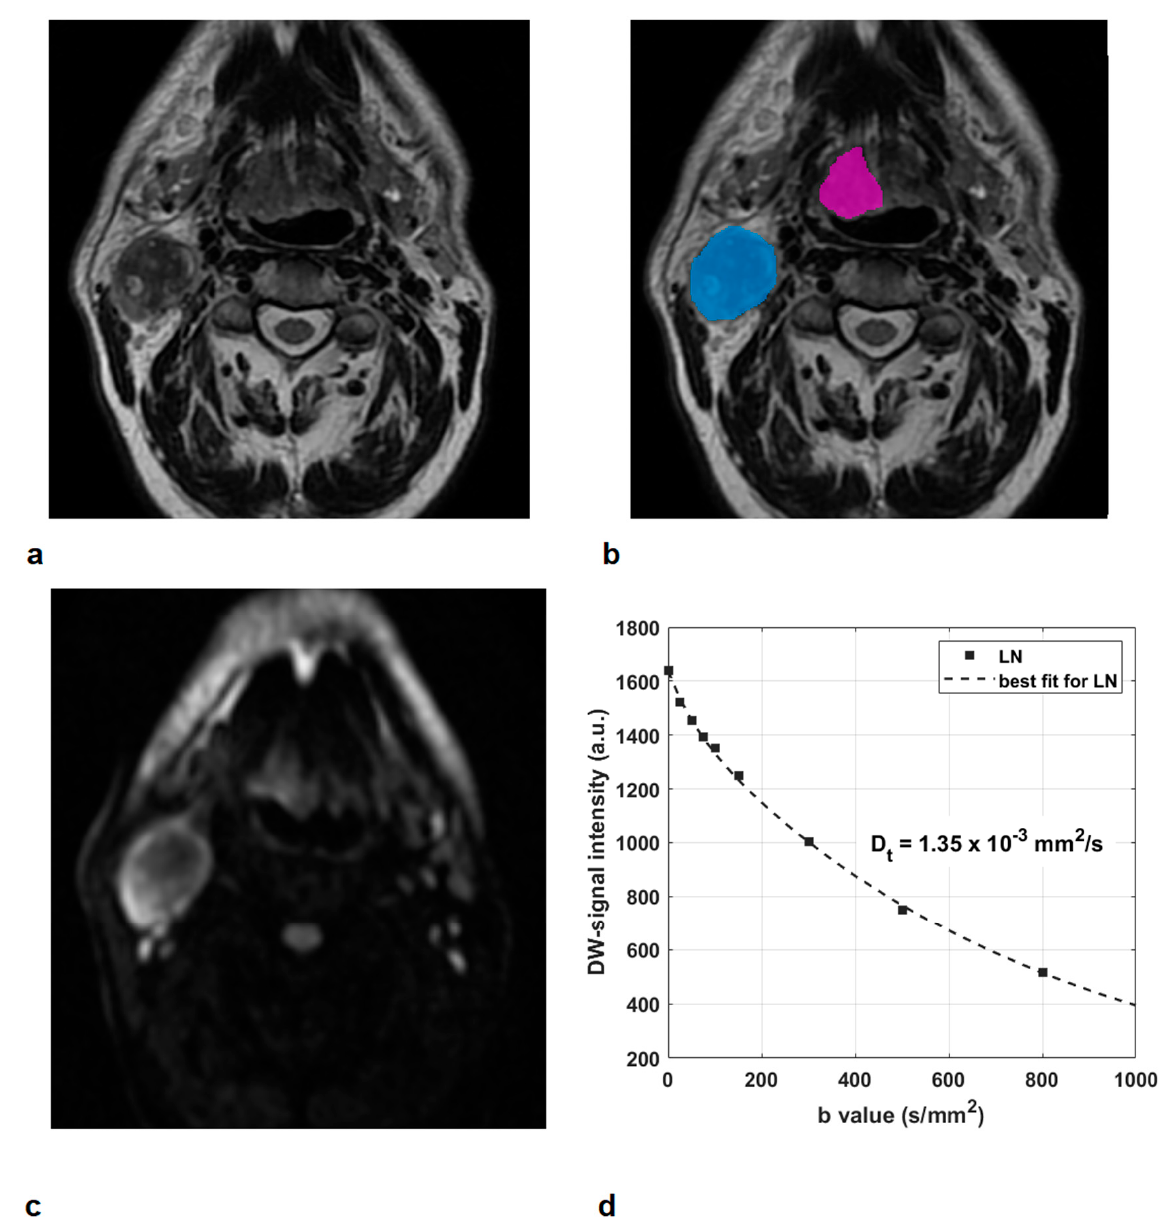
Figure 3. HPV-negative oropharyngeal squamous cell carcinoma of the base of the tongue in a 63-year-old moderate smoker and alcoholic man (Patient 62): T2-w images ( a , b ) show a primary tumor with an exophytic appearance and ulcerations (contour in magenta) and a large lymph node (LN) with extracapsular spread within IIa and IIb levels (contour in light blue). The corresponding DWI at b = 800 s/mm 2 ( c ) and DW-signal intensity curve at increasing b values of the LN ( d ). A moderate restriction of water molecule mobility was observed in the LN, with ADC and D t values of 1.52 and 1.35 × 10 − 3 mm 2 /s, respectively.